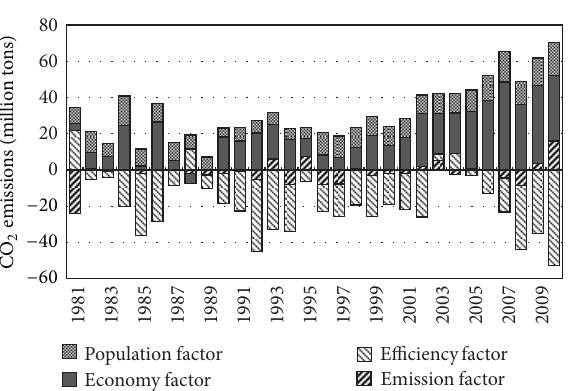
Figure 4: Decomposition results of urban residential consumption CO 2 emissions (1981–2010).